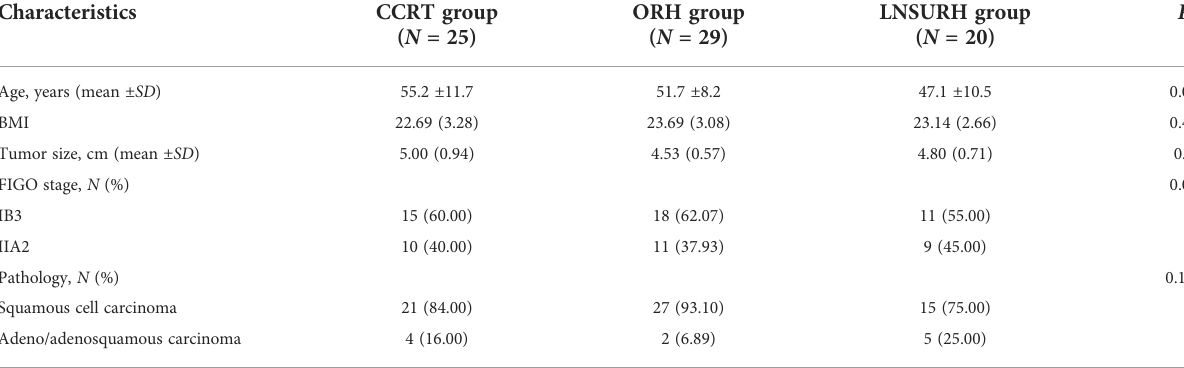
TABLE 1 Characteristics of the study